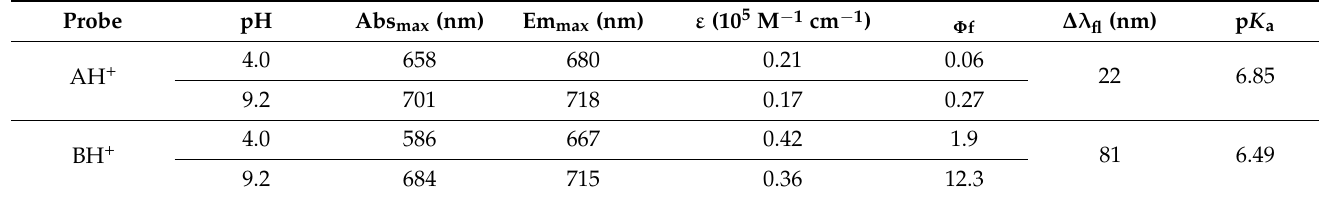
Table 1. Photophysical data of the